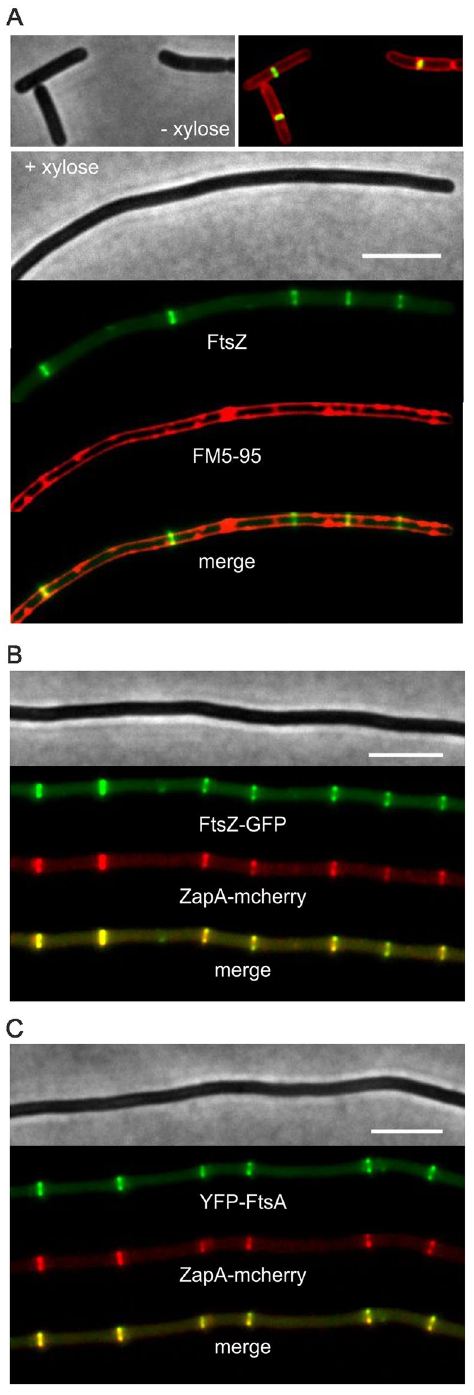
Figure 3. Effect of SepF overexpression on FtsZ, EzrA, ZapA and FtsA localization. Fluorescence light microscopy images of ( A ) strain GYQ298 ( amyE:: P xyl-sepF ftsZ::ftsZ-gfp ) expressing Ftsz-GFP, ( B ) s train GYQ30 ( amyE:: P xyl - sepF ezrA::ezrA-gfp ) expressing EzrA-GFP, and ( C ) strain GYQ212 ( amyE:: P xyl - sepF aprE::Pspac-yfp-ftsA zapA:Pxyl-mcherry-zapA ) expressing YFP-FtsA and mCherry-ZapA, grown without or with 1% xylose to induce SepF expression. Membranes were stained with FM5-95. Scale bar is 5 µ